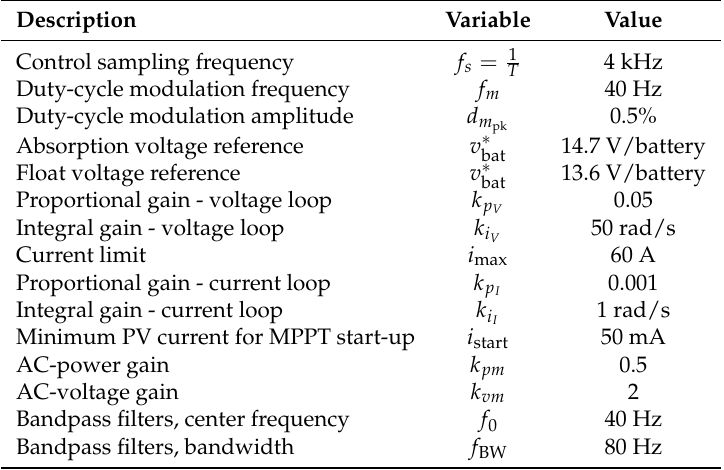
Table 1. Control